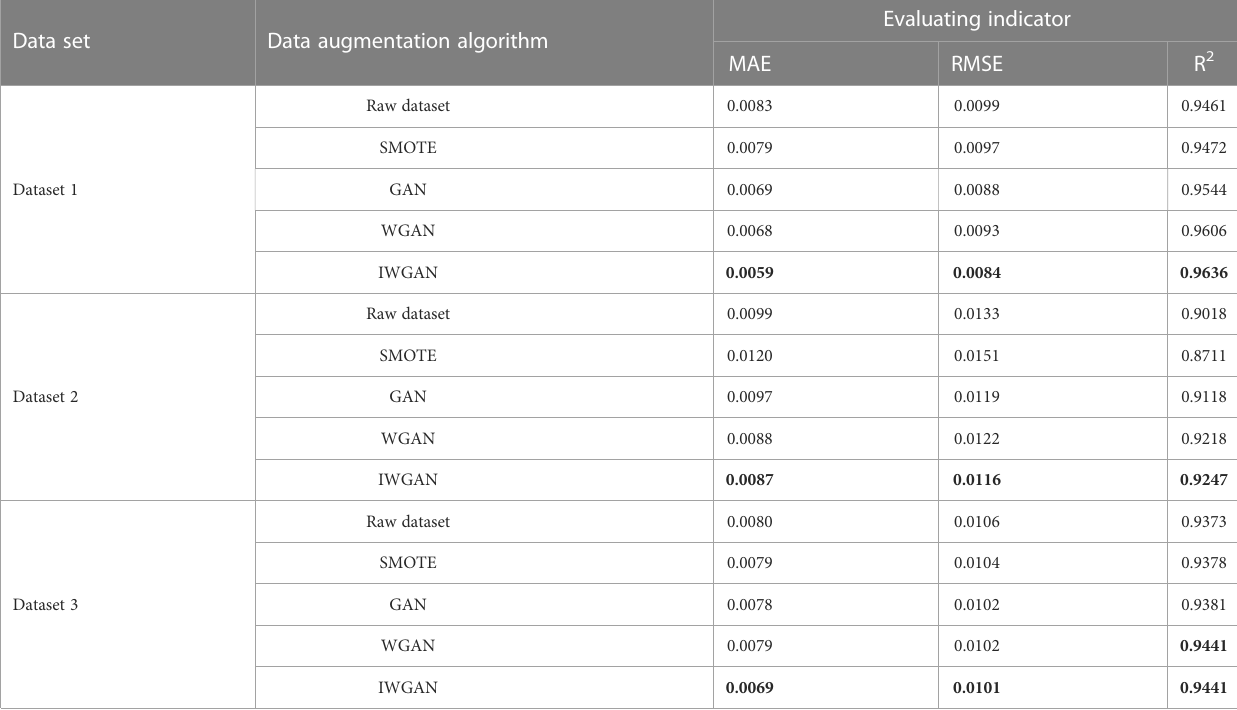
TABLE 3 Comparison of experimental results of models under different data augmentation